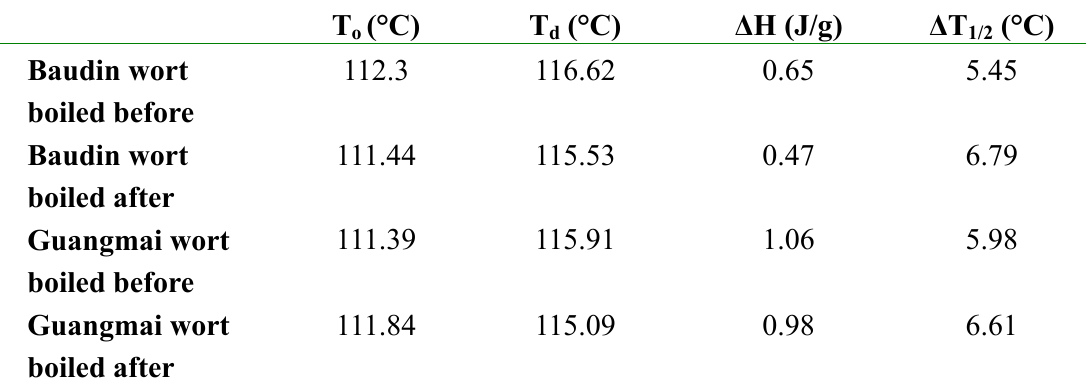
DSC characteristics of wort samples with the two varieties a